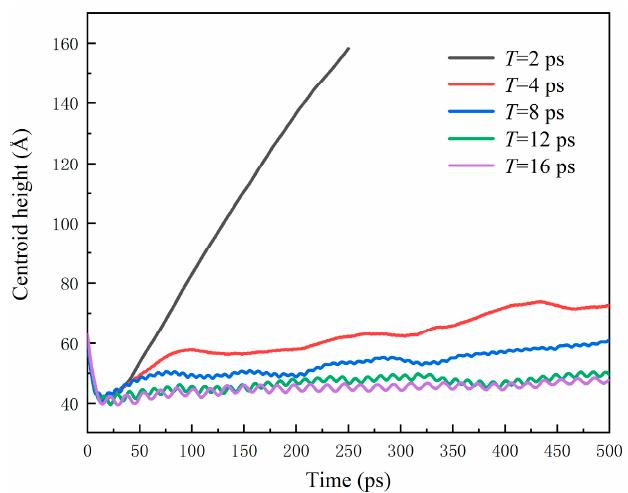
Figure 16. Time evolution of water nanodroplets impinging on surfaces with different vibration periods.